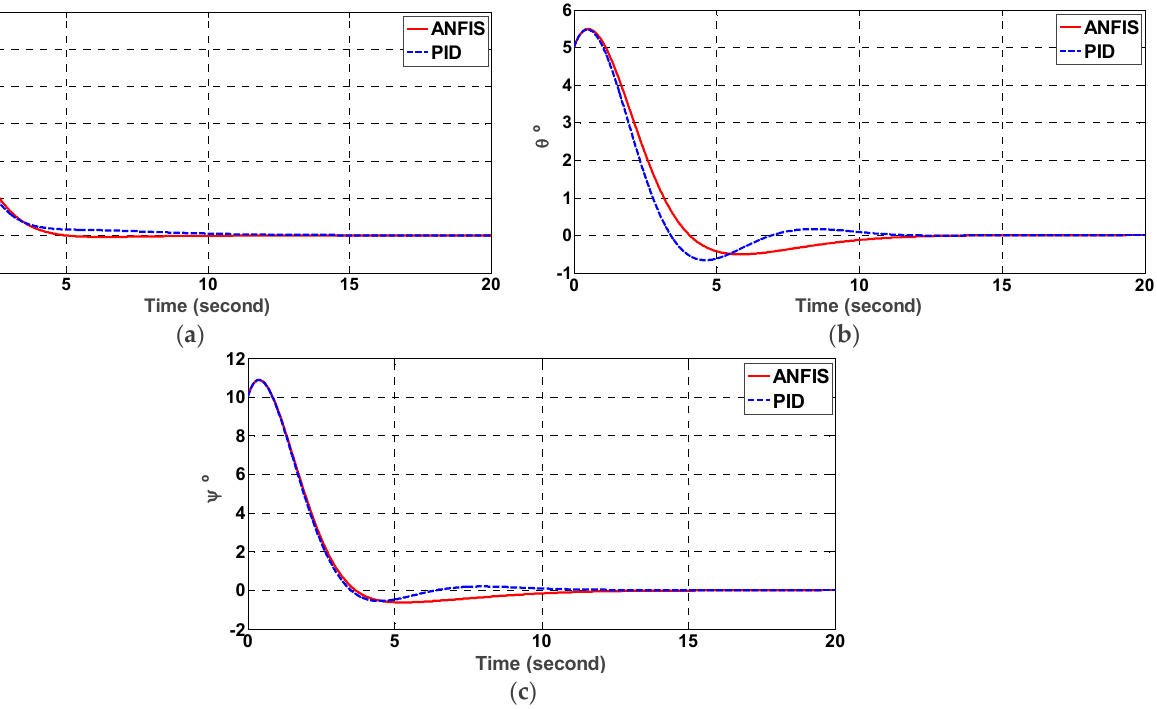
Figure 10. Comparison of Euler angles ( a ) φ , ( b ) θ , and ( c ) ψ using ANFIS and PID controllers in the presence of uncertainty.